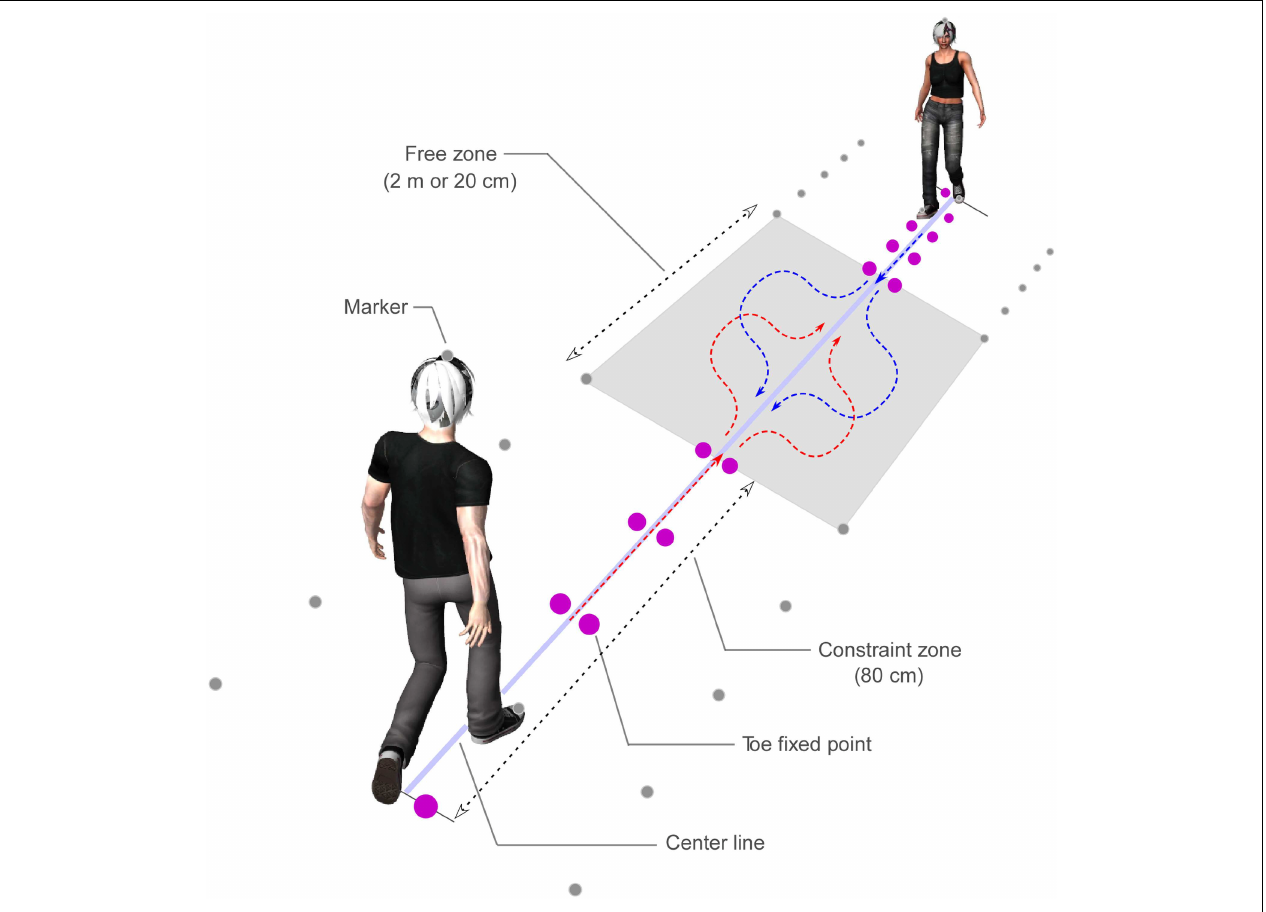
the constraint zone on the right and left. In the synchronization condition, the timing sounds were presented at the same time to two persons, whereas in the asynchronization condition, mismatched sounds with 200ms difference between the two participants were presented. In the starting foot side condition, the two participants began on the same or on opposite